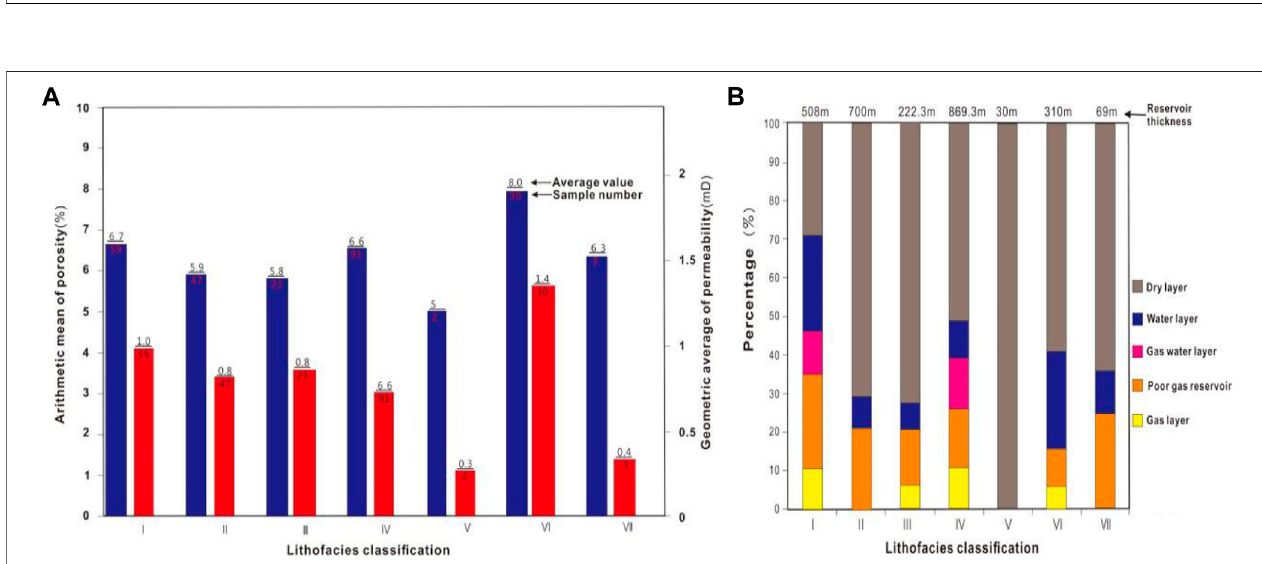
FIGURE15| Relationshipbetweenvolcanicreservoirphysicalproperties,effectivereservoirdistribution,andlithofaciestype.Notes:I — uppersubfacies,II — middle subfacies, III — lower subfacies, IV — thermal clastic fl ow subfacies, V — thermal wave subfacies, VI — air fall subfacies, and VII — volcanic neck subfacies. (A) Histogram of the lithofacies physical property relationship of the volcanic reservoir. (B) Histogram of the lithofacies effective reservoir relationship of the volcanic reservoir.